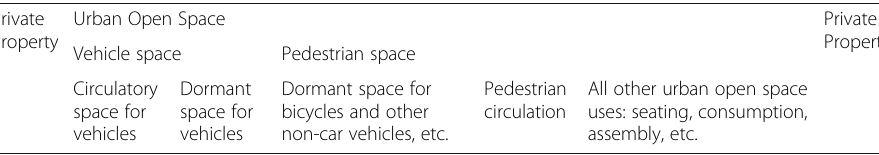
Table 1 Conceptual model of the legal